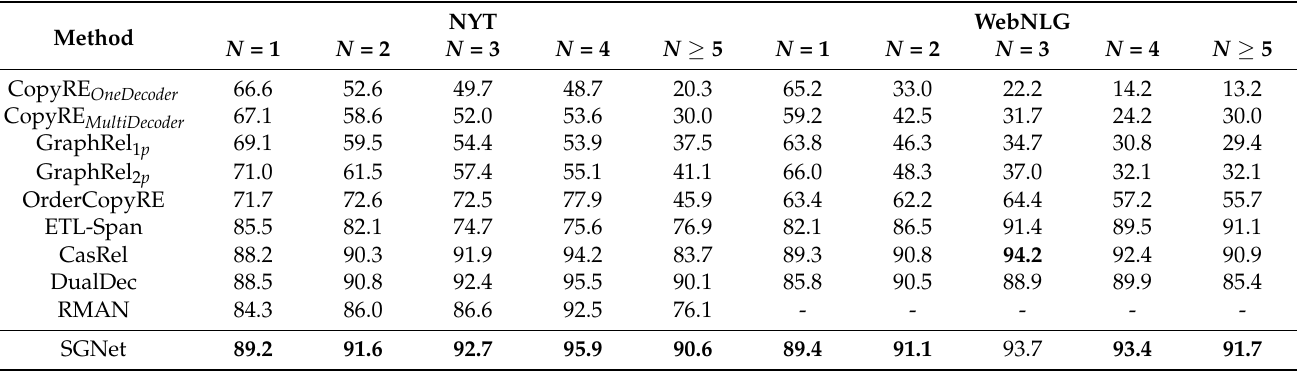
Table 3. F1 score of extracting relational triples from sentences with a different number (denoted as N ) of